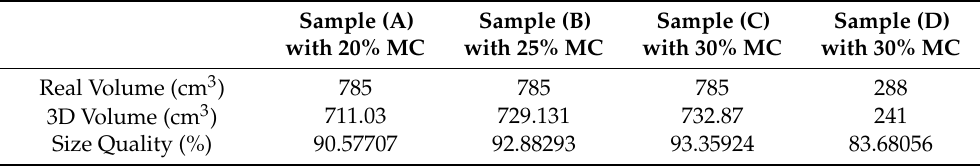
Table 3. The ratio of the size of the volume between Real Volume and 3D Volume.